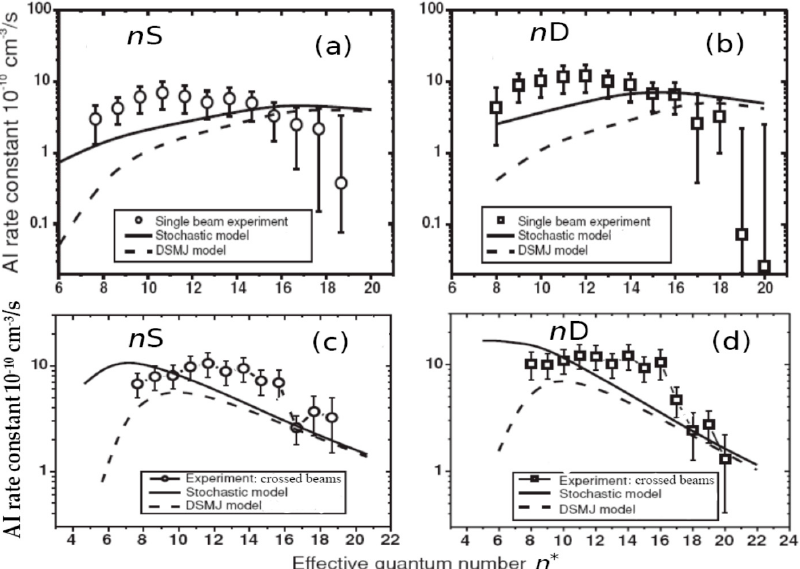
Figure 12. Associative ionization rate constants for Na*(nl) + Na(3s) collisions in a single beam [53] (frames ( a , b )) and in two orthogonal crossed beams [66] (frames ( c , d )), T = 600 K.